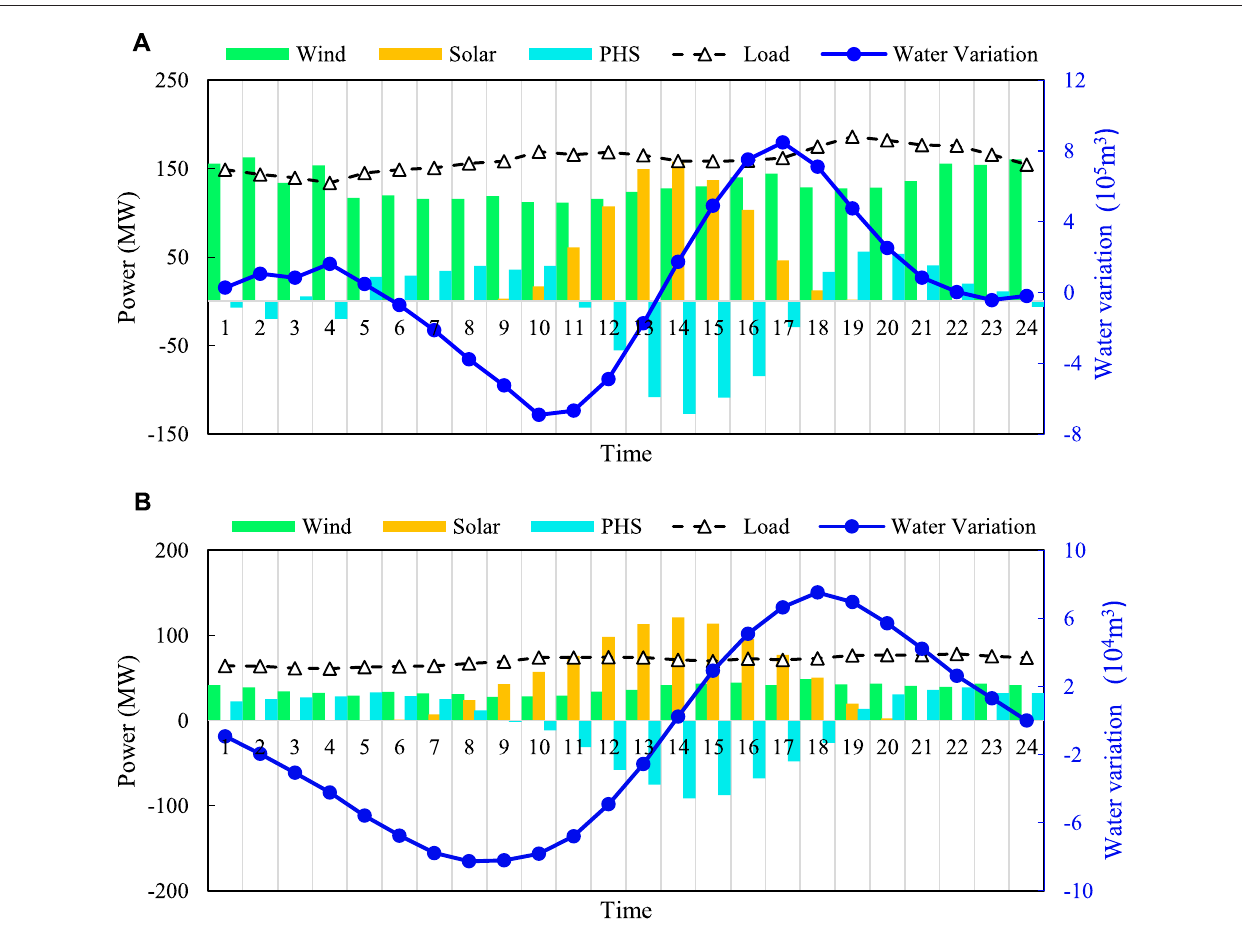
FIGURE 14 | Output of goaf-PHS system components and water volume variation for the daily regulation case. (A) Average component output and water volume variation of the system using the data of the 15th of January ( α w (cid:2) 0 . 8); (B) average component output and volume water variation of the system using the data of 15th July ( α w (cid:2) 0 .